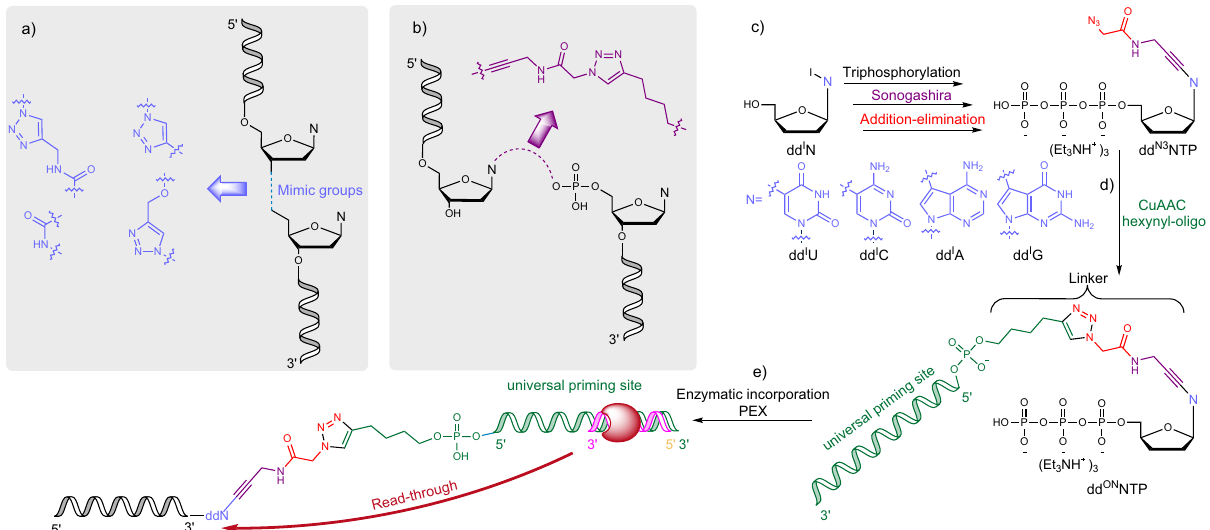
Fig. 2 The general principles of chemical conjugation of nucleic acids. a Previously reported ribose-to-ribose conjugated analogues, b our proposed nucleobase-phosphate conjugation analogues, c synthesis of azido group-bearing ddNTPs, d oligo-tethered ddNTP derivatives and e dd ON NTP enzymatic incorporation and